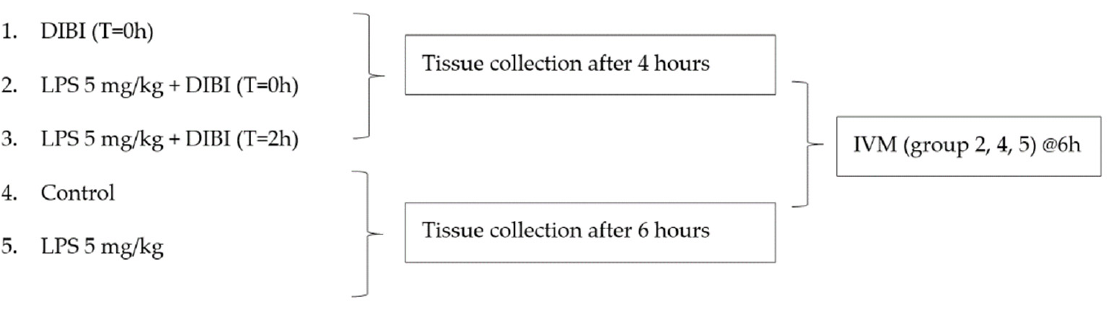
Figure 7. Experimental groups.